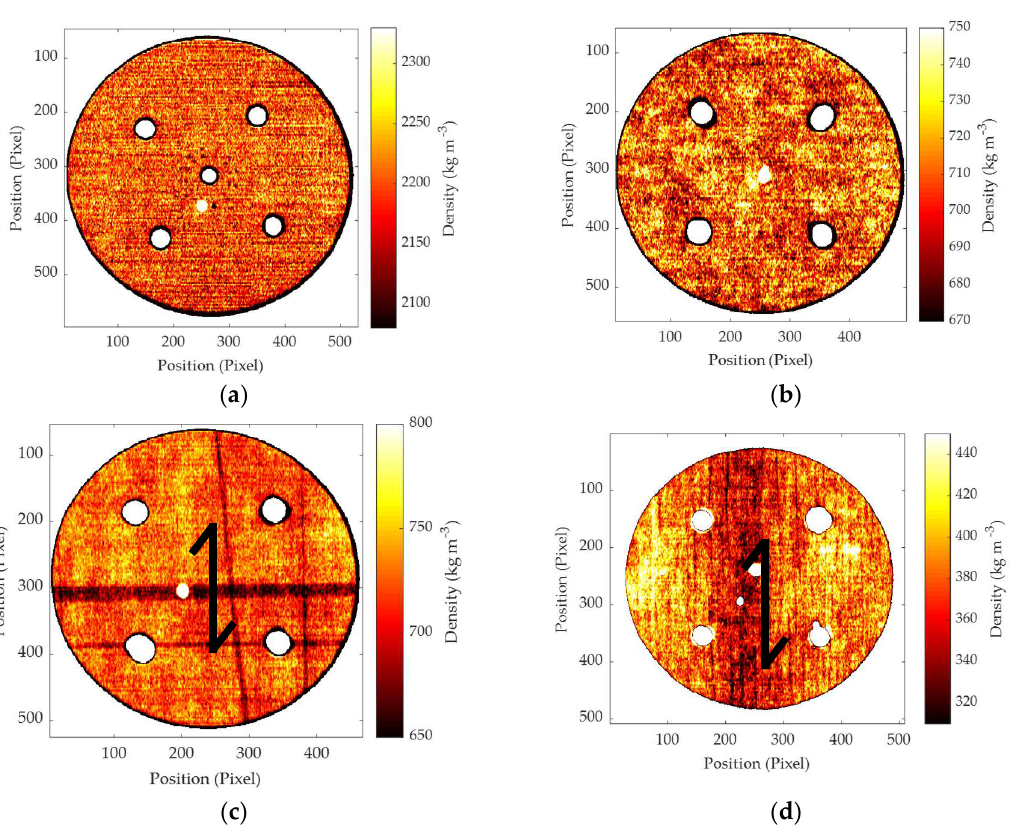
Table 1. Machined material thicknesses and physical properties. Moisture content before machining was determined by the gravimetric method; the density of the machined samples was determined after equilibration at 20 °C and 65% relative humidity (RH).